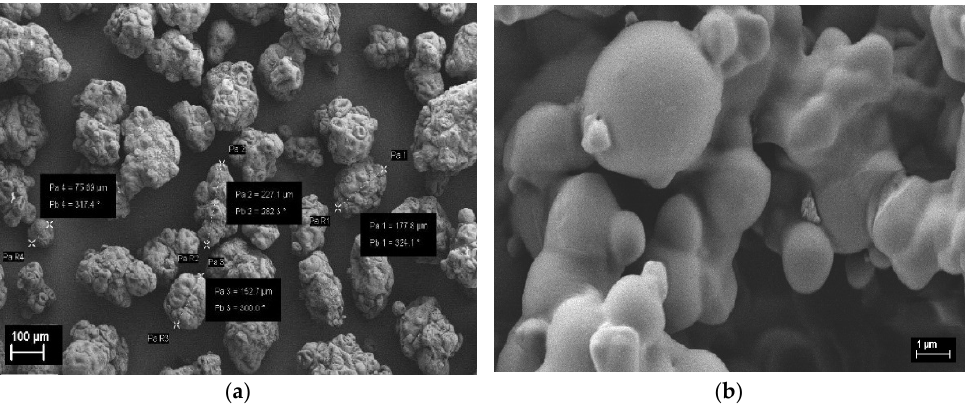
Figure 1. Scanning electron microscopy (SEM) micrographs of poly(vinyl chloride) (PVC) with the following morphological structures: grains with a size of 75–227 μ m ( a ) and spheres with a diameter of 3.5 μ m ( b ).